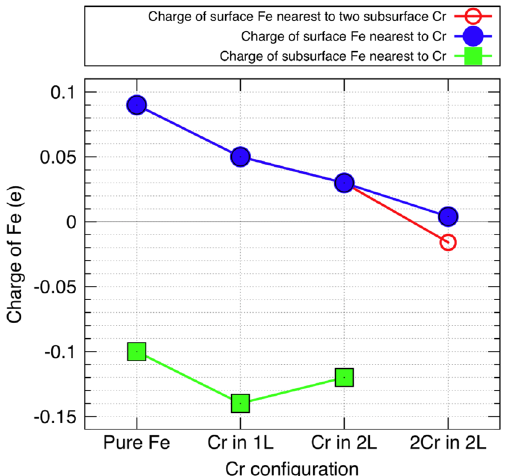
Figure 7. The charge of an Fe atom versus Cr configurations (with the neutral atom, of charge 0 e , as the reference level). The axis labels ‘Pure Fe’, ‘Cr in 1L’, ‘Cr in 2L’ and ‘2Cr in 2L’ refer to pure Fe surface, one Cr atom in the surface layer, one Cr atom in the subsurface layer and two Cr atoms in the subsurface layer at sites 8 and 9 (Fig. 1). The green curve with square markers shows the charge of the subsurface Fe atom nearest to the Cr atom. The blue curve with filled circles gives the charge of the surface Fe atom nearest to the Cr atom. For the ‘2Cr in 2L’ case, the red branch (open circle) shows the charge of the Fe atom at site 5, and the blue branch (filled circle) shows the charge of an Fe atom at sites 2 and